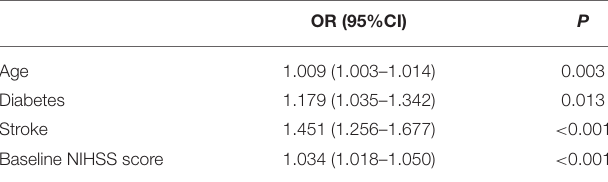
TABLE 5 | Subgroup multivariable analyses of the factors associated with 90-day outcomes in patients with ACI complicated with TABLE 3 | Multivariable analyses of the factors associated with the 90-day outcomes. OR (95%CI) P